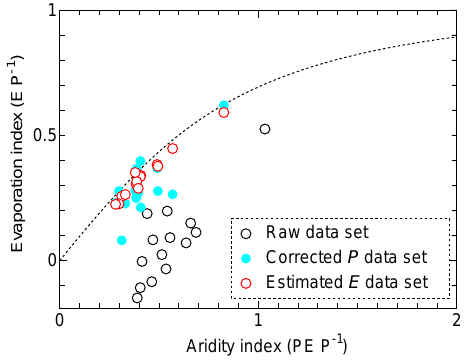
Figure 3. Raw, corrected P , and estimated E data sets plotted with Budyko